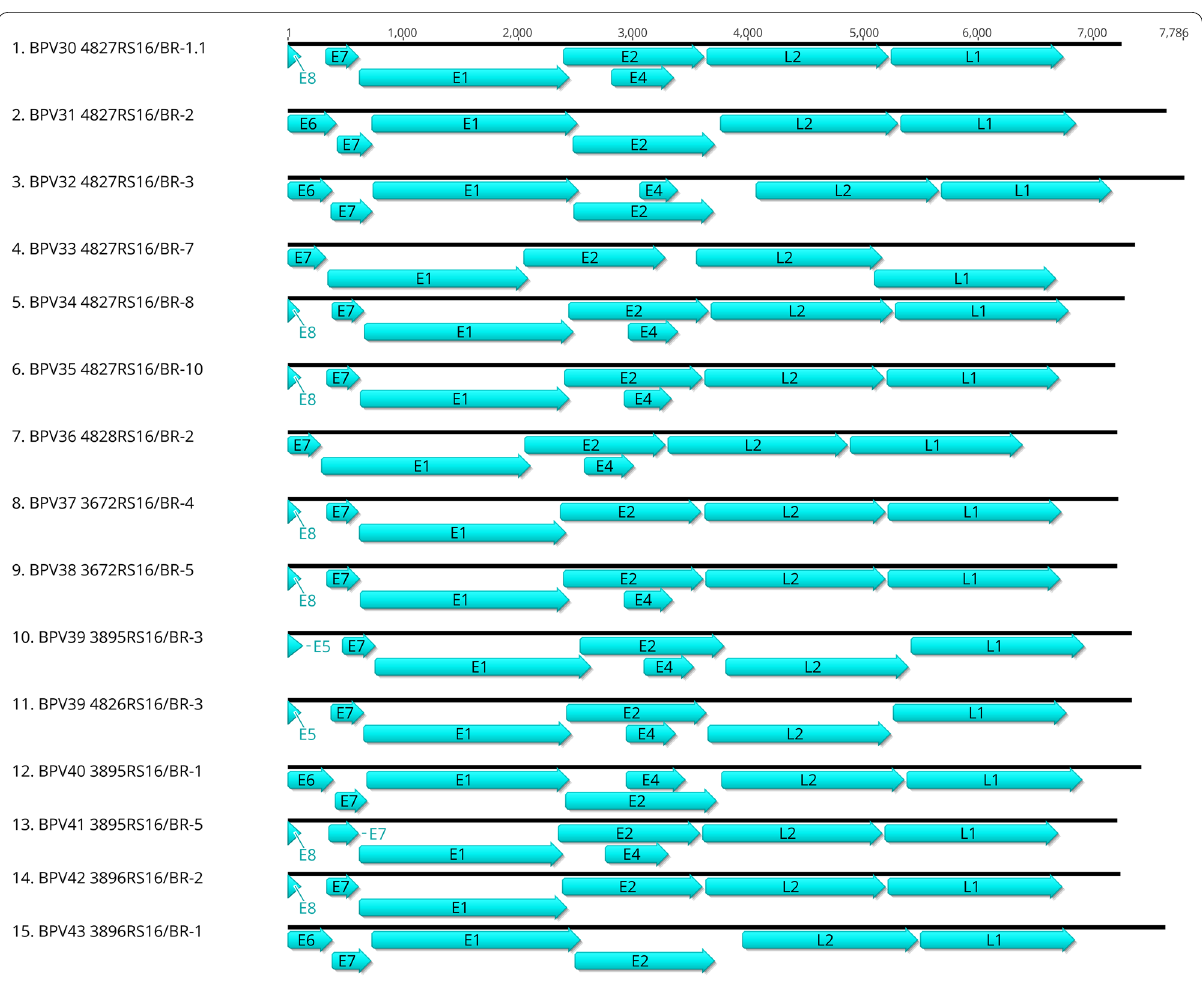
Fig. 2 Genomic organization of the putative new BPV types found in this study. The first nucleotide in ORF5, ORF6, ORF7 or ORF8 was assigned number 1 in the sequences. The putative new BPV types contained five to eight ORFs encoding early (E1, E2, E4, E5, E6, E7 and E8) and late (L1 and L2)